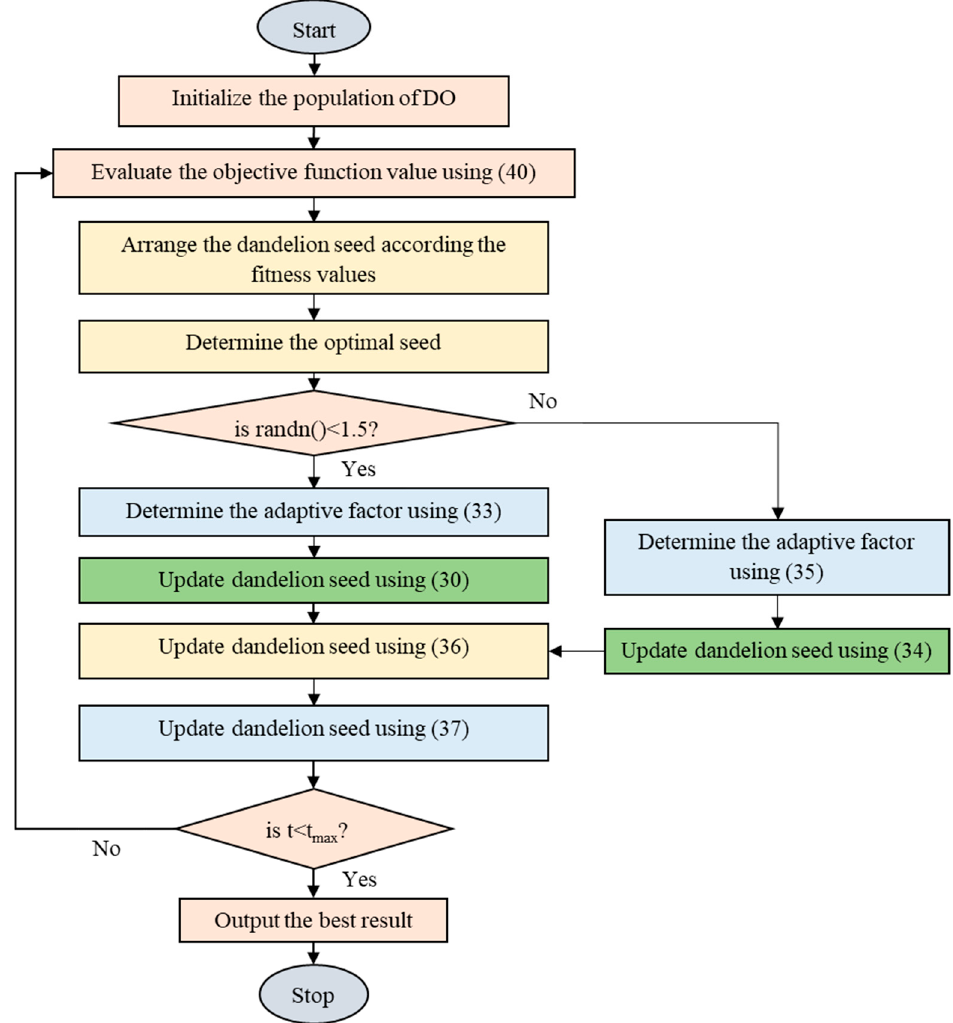
Figure 4. The flowchart of the proposed DO.